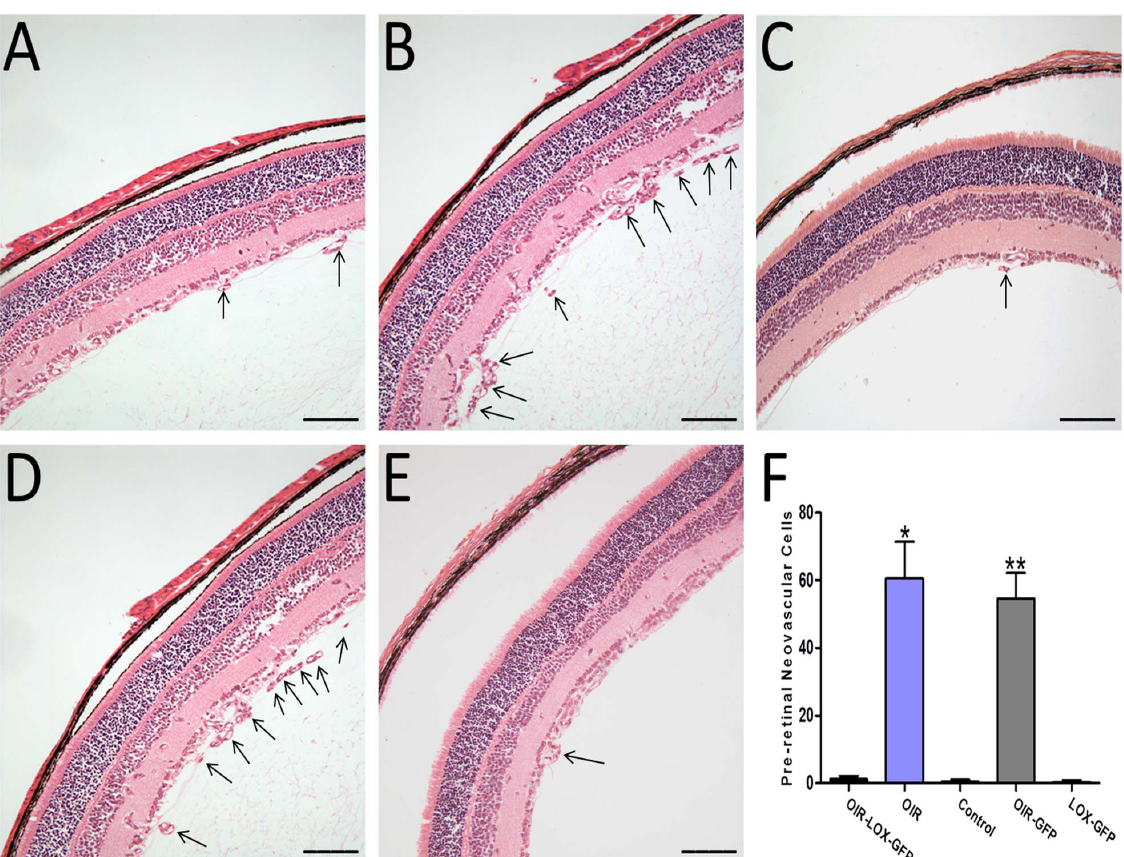
Figure 5. Effects of 15-LOX-1 gene transfer on pre-retinal neovascularization in mice with oxygen-induced ischemic retinopathy. At postnatal day 17, the eyeballs of OIR-LOX-GFP group, OIR group, Control group, OIR-GFP group and LOX-GFP group mice were fixed, sectioned, and stained with H&E. A: OIR-LOX-GFP group, B: OIR group, C: Control group, D: OIR-GFP group, E: LOX-GFP group. Arrows indicate pre-retinal neovascular cells. Magnification 6 200. Scale bar=50 um. F: The average numbers of pre-retinal neovascular cells (means 6 SD) of OIR-LOX-GFP group, OIR group, Control group, OIR-GFP groupandLOX-GFP group mice usingone-way ANOVA test.Pre-retinal neovascular cells were counted on eight non-continuous sections per eye and averaged. OIR-LOX-GFP group versus OIR group *p , 0.05; OIR-LOX-GFP group versus OIR-GFP group **p , 0.05, n=8.